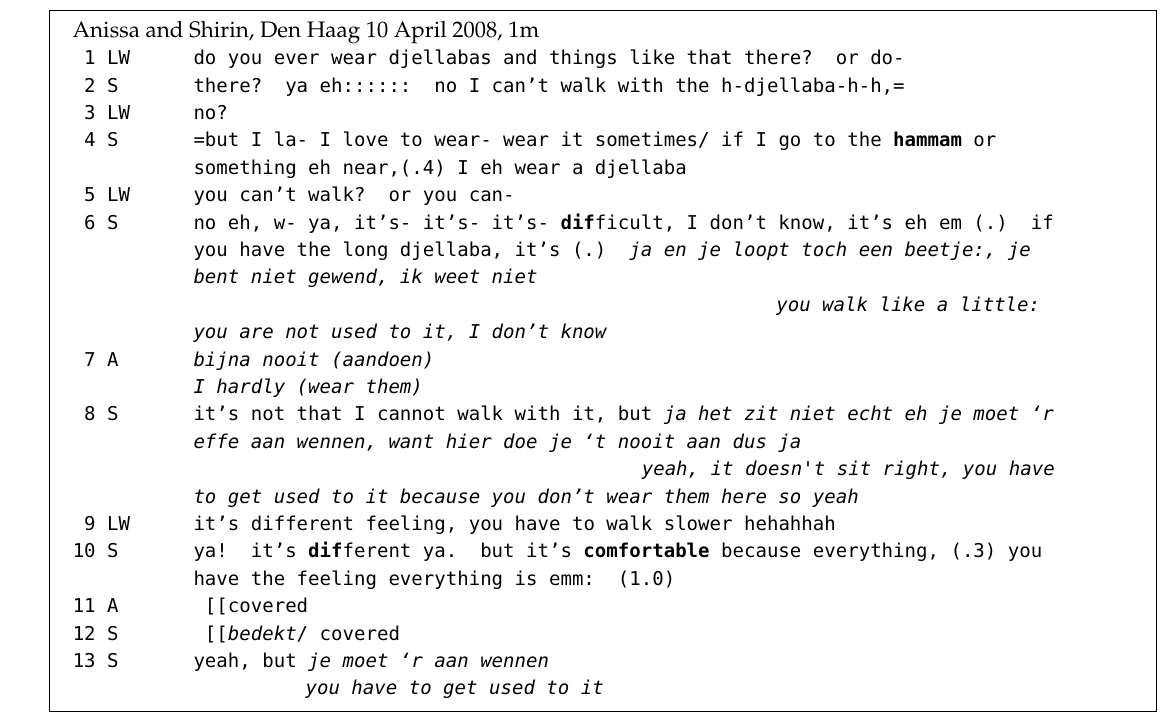
Box 1. Interview extract: Walking in a djellaba 1